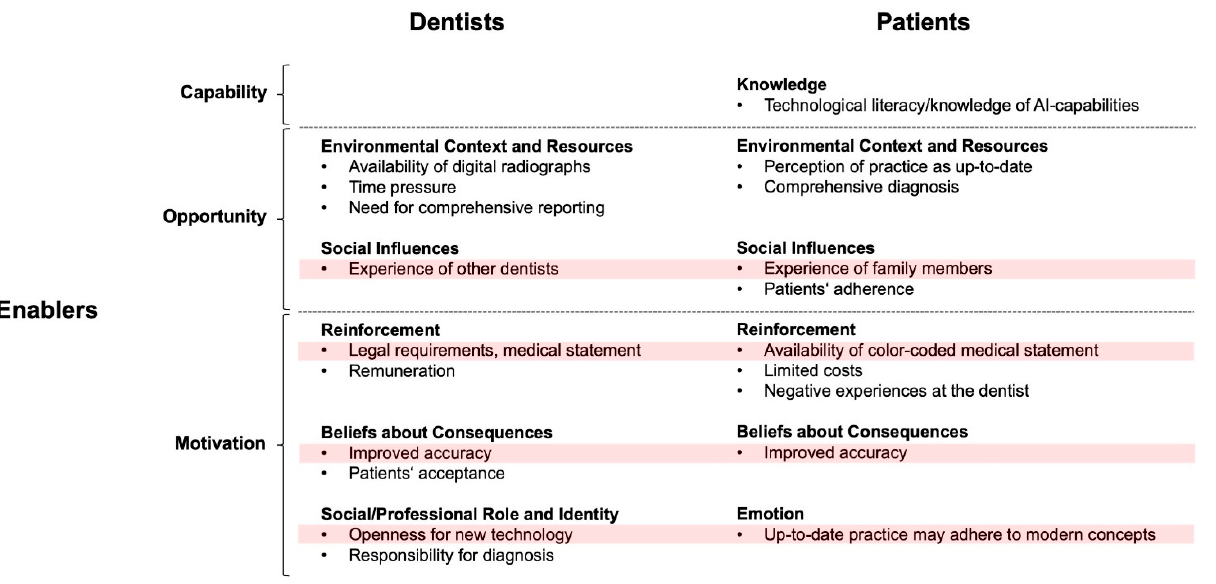
Figure 2. Identified enablers, conflicting themes and barriers for implementation of a new AI-tool in dental X-ray diag- nostics. Eight dentists were interviewed, revealing 20 themes for this topic. From five patient interviews, 16 themes were derived. Themes were classified according to the different TDF domains (Knowledge, Environmental Context, Resources, etc.), as well as along the COM-B domains (Capability, Opportunity and Motivation) and as enablers, conflicting themes and barriers. Themes recurring for both dentists and patients are highlighted in pink. 3.1. Enablers for Dentists Availability of digital radiographs (Opportunity–Environmental Context and Re- sources): Obviously, the availability of digital radiographs is required to seamlessly use an AI-based diagnostic radiographic assistance tool. Six of the eight interviewed dentists